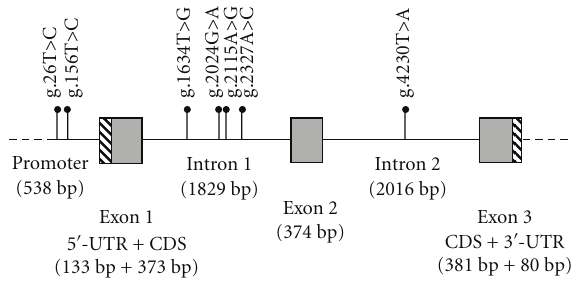
Figure 2: Genomic organization of the horse MSTN gene. Exons are shown as boxes. Solid boxes indicate protein coding regions. Untranslated regions are shown as striped boxes. Size of the sequenced regions of the promoter, exons, and introns is reported. Polymorphisms, indicated according to GenBank accession number GQ183900, are reported on the genomic organization of the